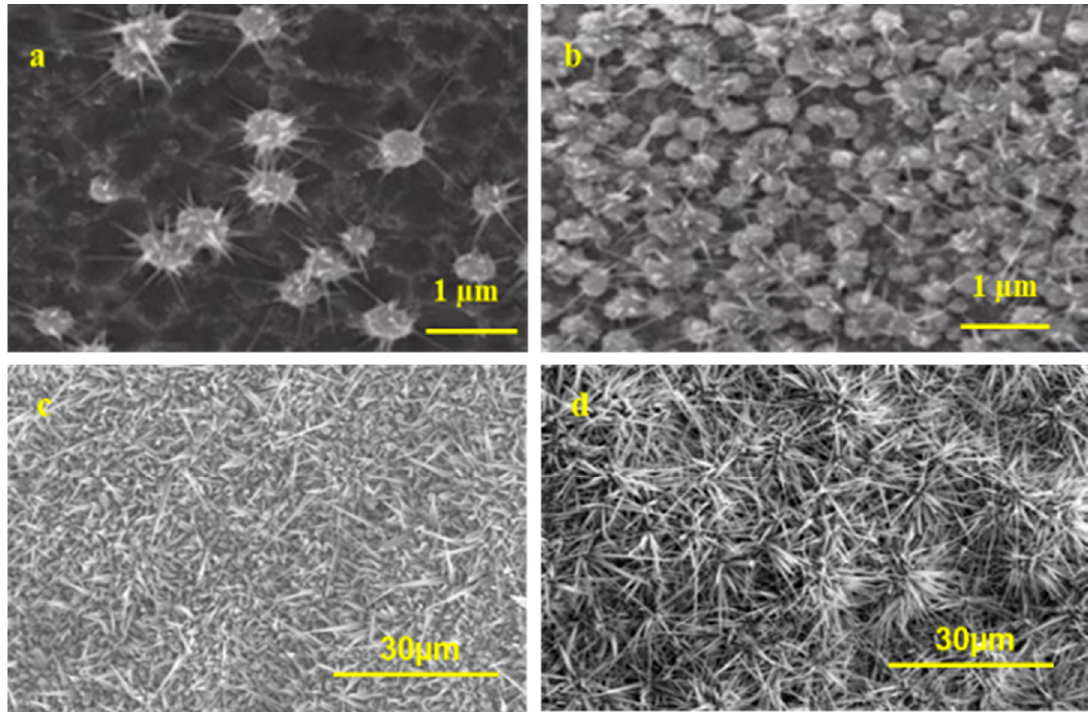
Figure 4. SEM images of gallium oxide on quartz, which was obtained by oxidation at different temperatures as follows: 800 °C without ( a ) and with Ag ( b ); 1000 °C without ( c ) and with Ag ( d ). The growth density of gallium oxide has significantly increased in the presence of the Ag catalyst at 800 °C. Similarly, at 1000 °C, the density and the length of Ga 2 O 3 nanowires were greatly enhanced due to the presence of the Ag catalyst.